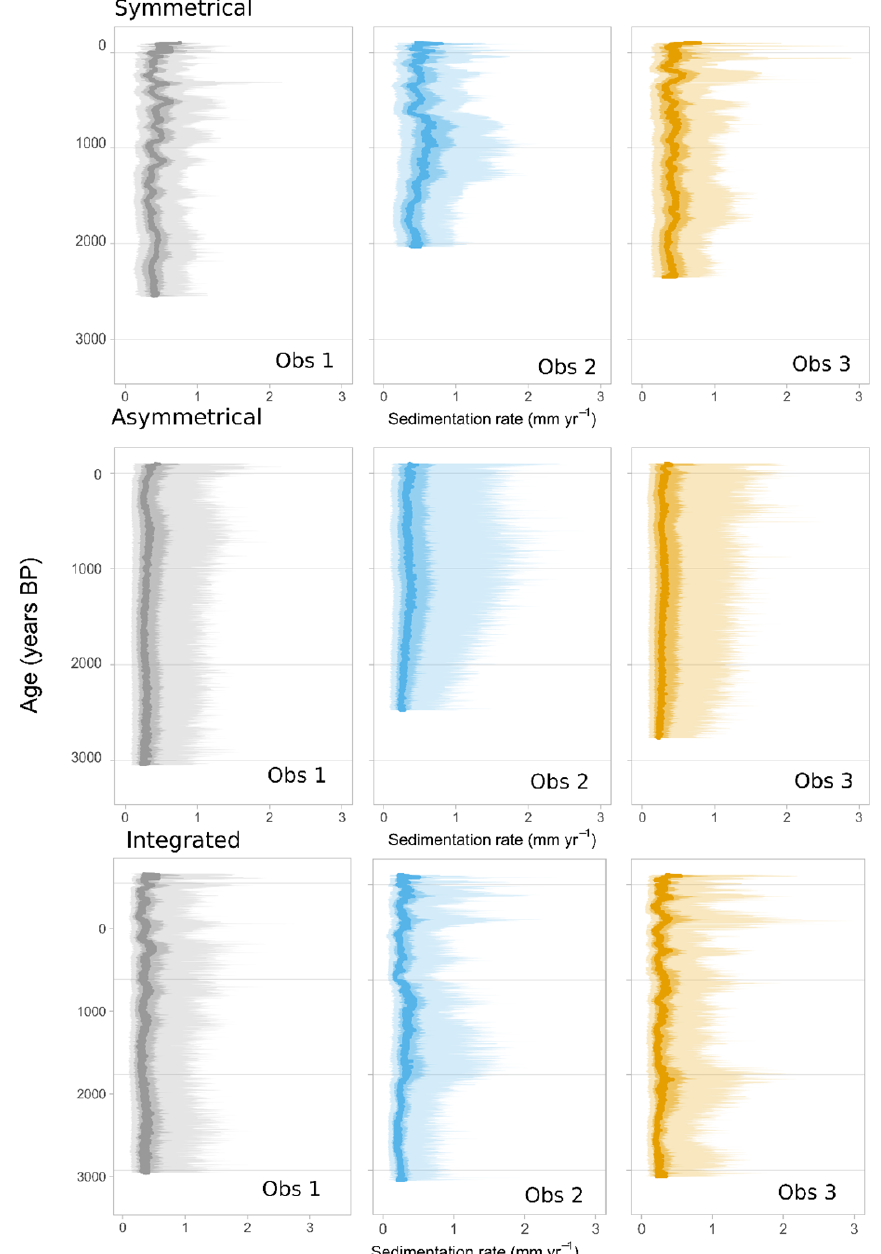
Figure A6. Sedimentation rates for each observer for the symmetrical varve-only model, asymmetrical varve-only model, and integrated